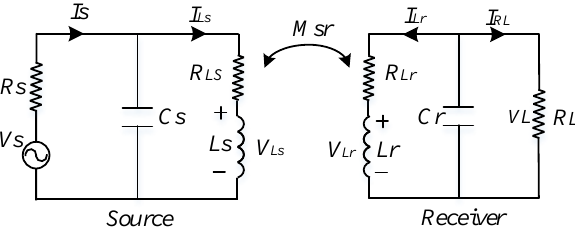
Figure 5. Equivalent circuit model of wireless power transfer (WPT).